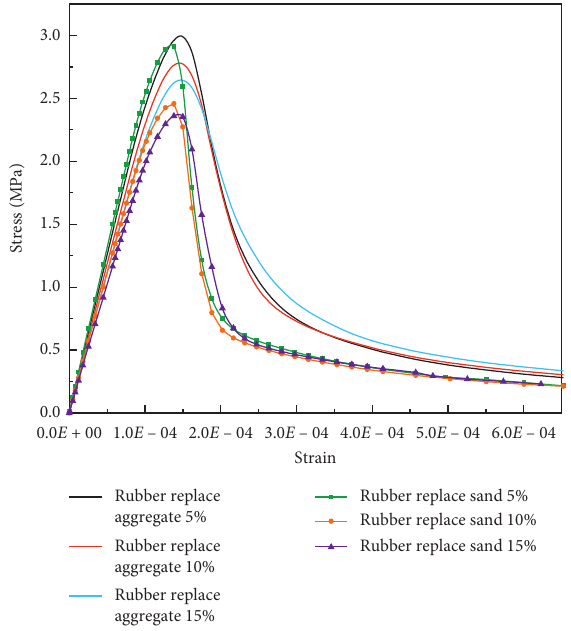
Figure 24: Mean stress-strain curves of rubber replacing sand and aggregate models.